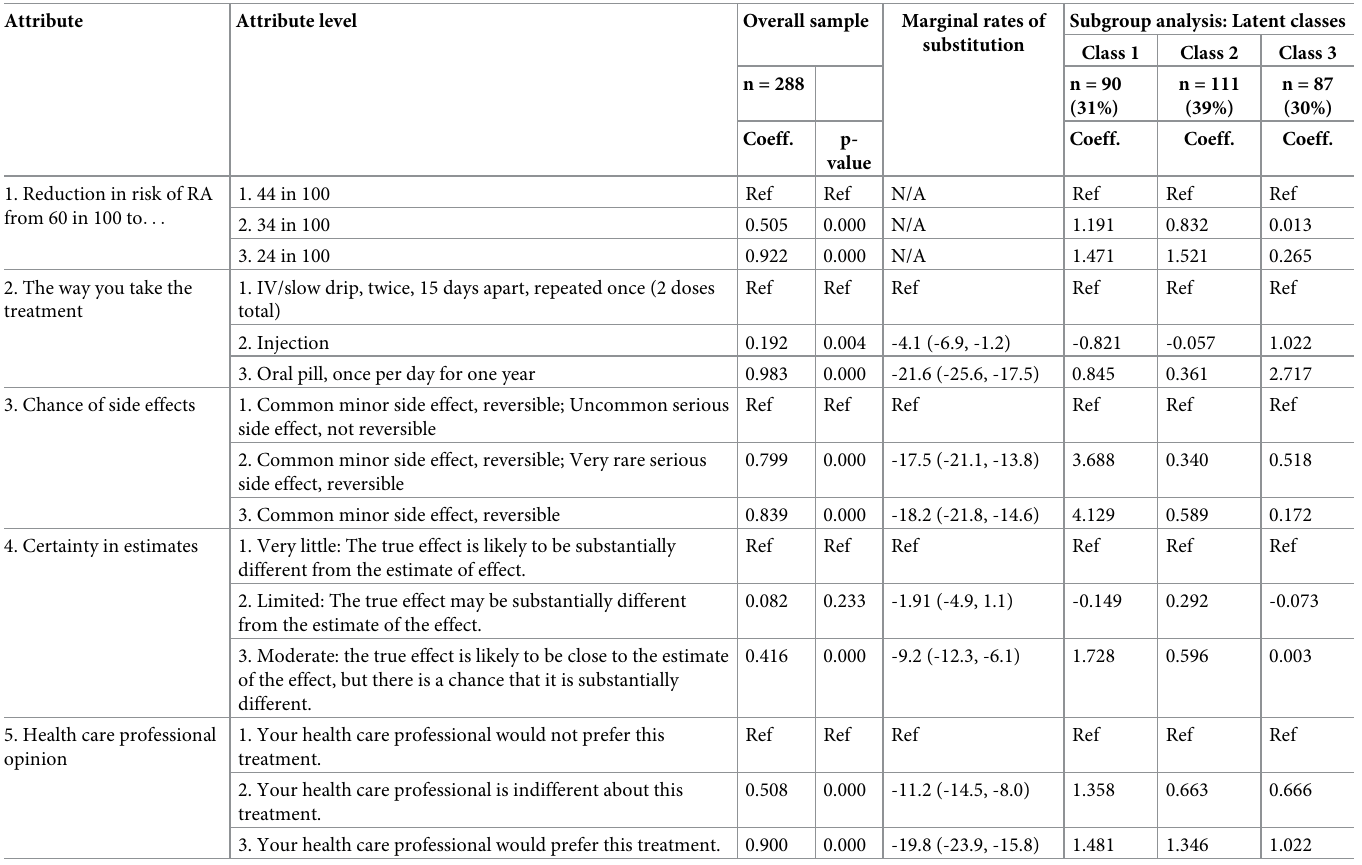
Table 4. Estimated coefficients from conditional logit